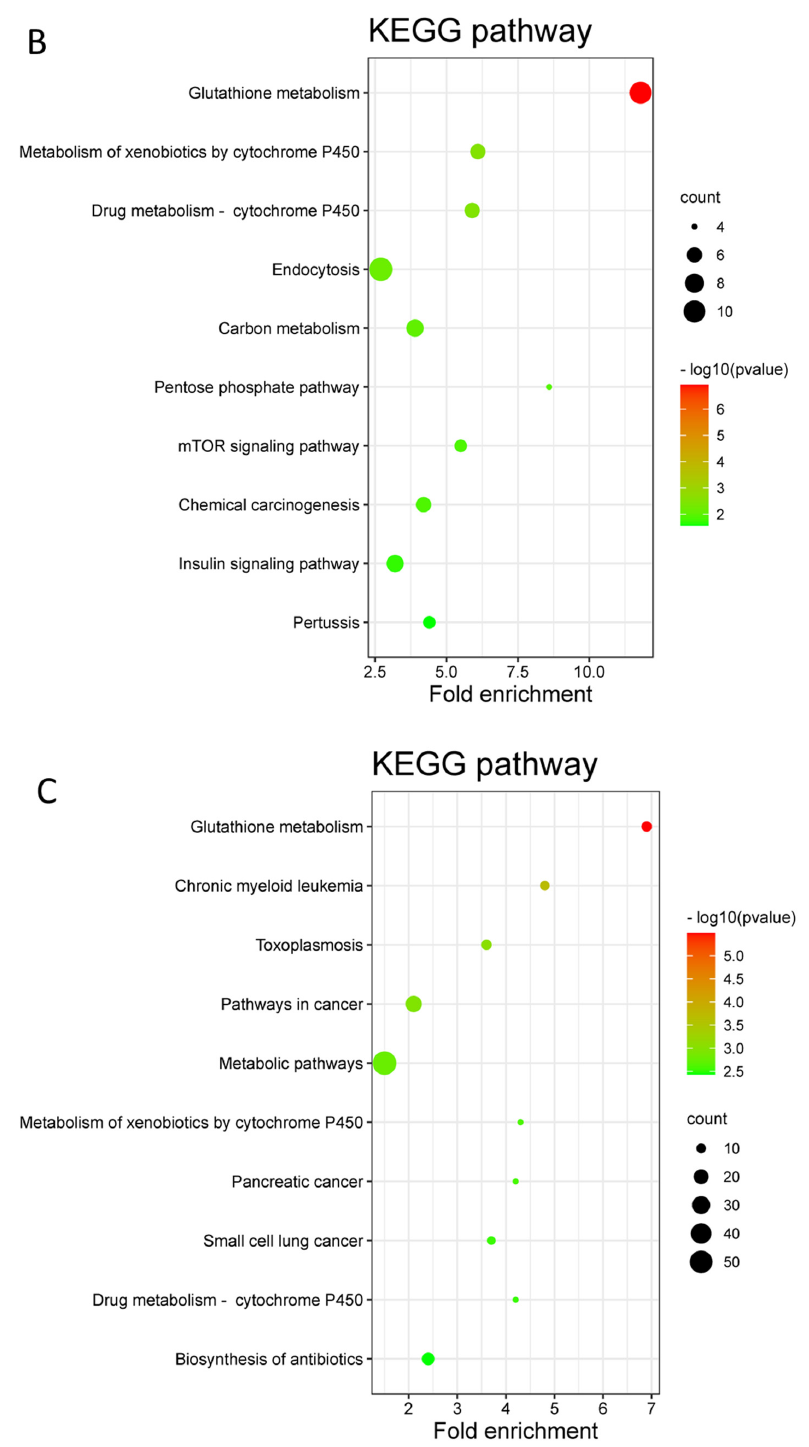
Figure 4. Numbers of differentially expressed proteins (DEPs) derived from different treatments (in four biological replicates) compared with the solvent control ( A ). Red and blue bars represent up- and downregulation, respectively. KEGG pathway enrichment analysis of DEPs for Hepa1c1c7 cells treated with 30 µM of PG ( B ) and t-BHQ ( C ). Only the top ten enriched terms were plotted on the graphs, and the complete results of enrichment analysis can be found in Table S3 in the Sup- plementary Materials. Results derived from four independent experiments. PG, pyrogallol; t-BHQ, tert-butylhydroquinone; KEGG, Kyoto Encyclopedia of Genes and Genomes; DEPs, differentially expressed